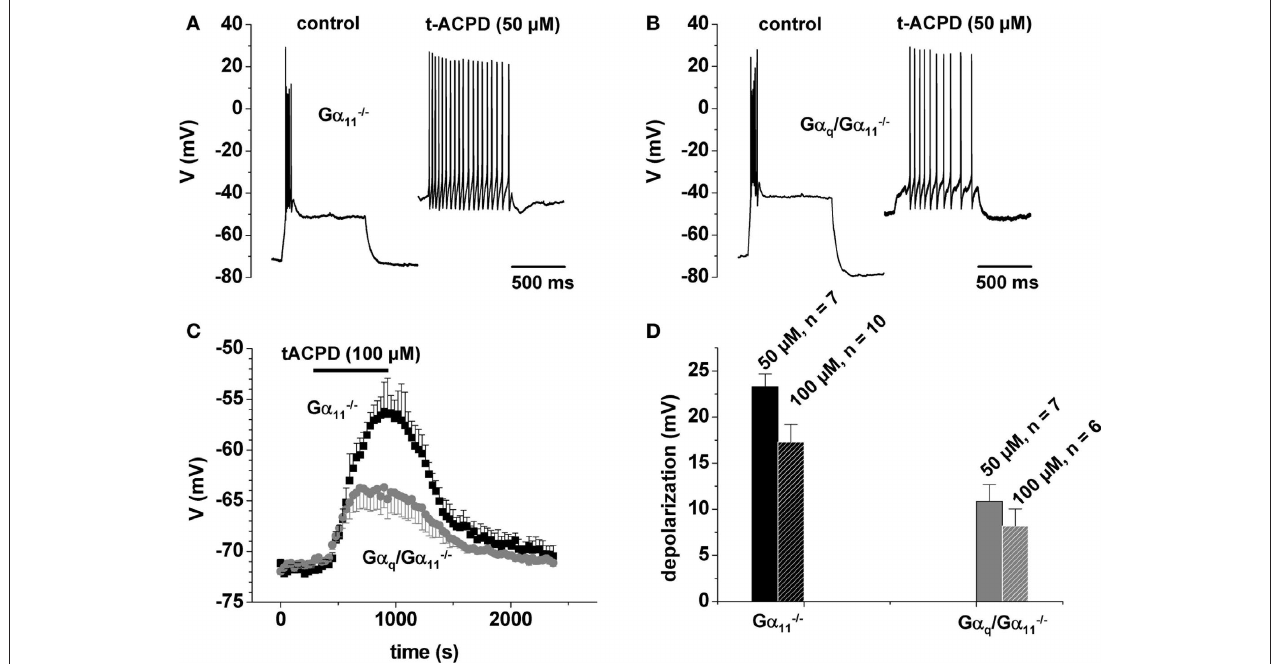
FiGure 2 | t-ACPD effect on firing properties. (A,B) Functional consequences of t-ACPD administration during current clamp recordings in a control mouse (A) and in G α /G α − / − (B) . (C) Mean voltage vs. time plot (black squares, control animal; gray circles, G α q 11 bar graph representation of the depolarization induced by two different substance concentrations as